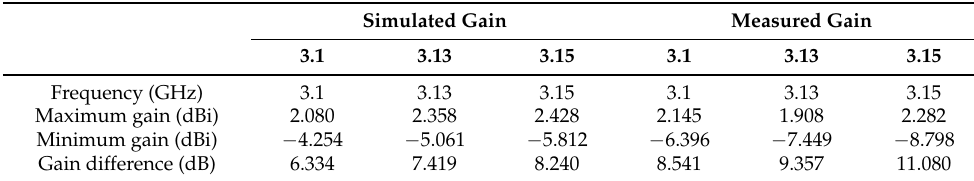
Table 5. Comparison of the simulated and measured gain difference of the proposed antenna (0 ◦ ≤ ϕ ≤ 360 ◦ and 0 ◦ ≤ θ ≤ 90 ◦ ).